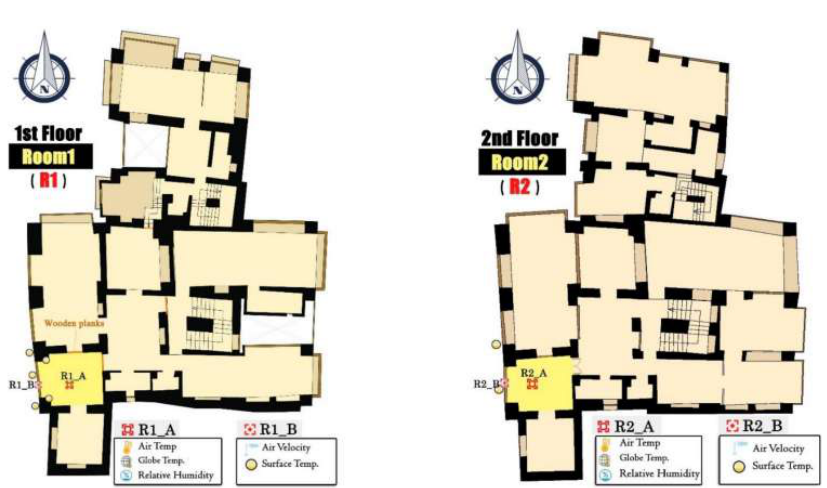
Figure 12. First and second-floor plans with the data loggers